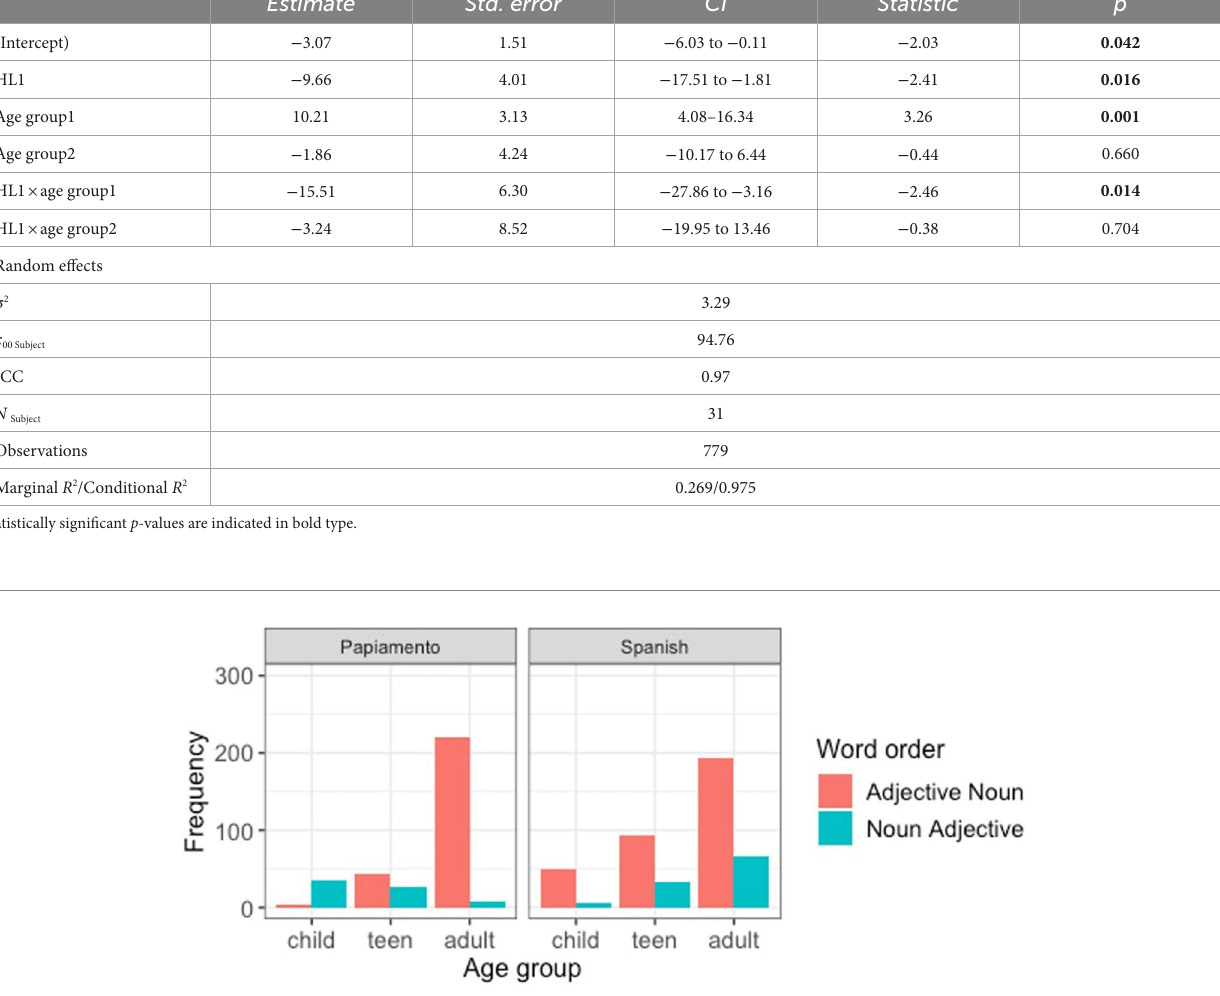
FIGURE 5 Word order preference for Dutch as a matrix language, by age group by heritage community.